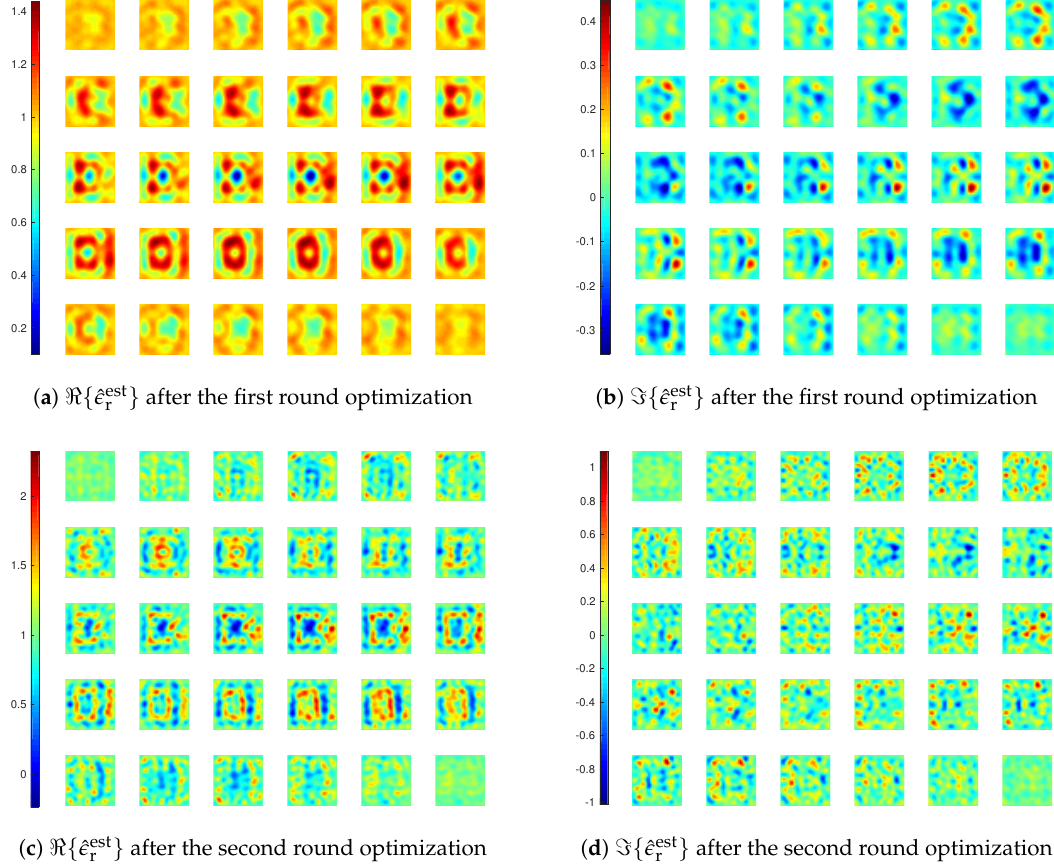
Figure 12. Reconstruction results of inversions with LSIE for Example 3 .